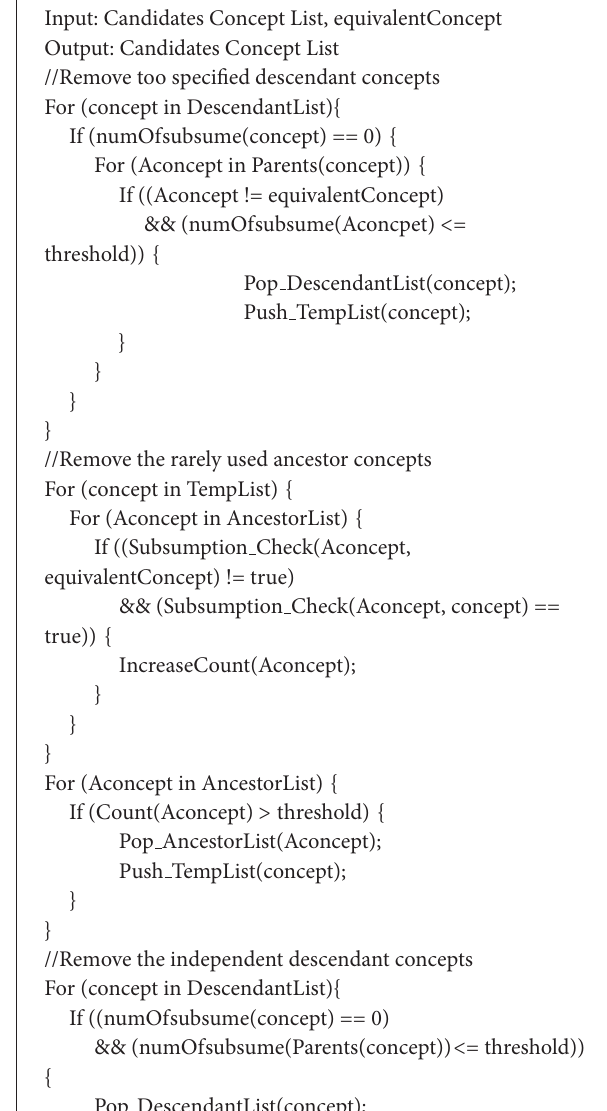
Algorithm 2: Algorithm of module extraction (candidates concept list extracting step).